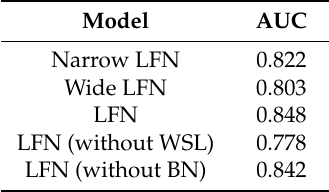
Table 7. AUC of LFNs on the validation